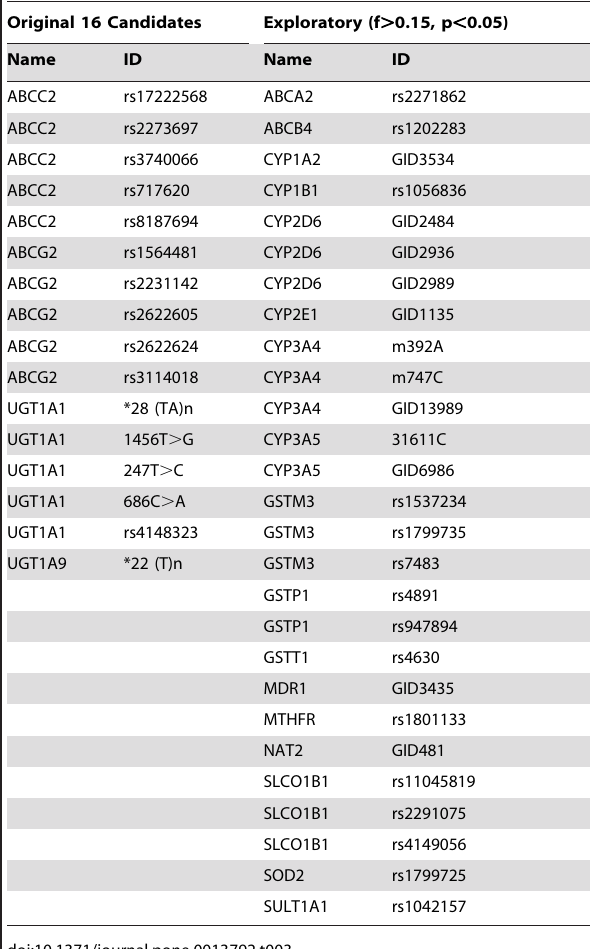
Table 3. List of 4 Candidate genes with 16 SNPs and 17 exploratory genes with 27 SNPs having minor allele frequencies (f) . 0.15 and allelic association test p , 0.05.